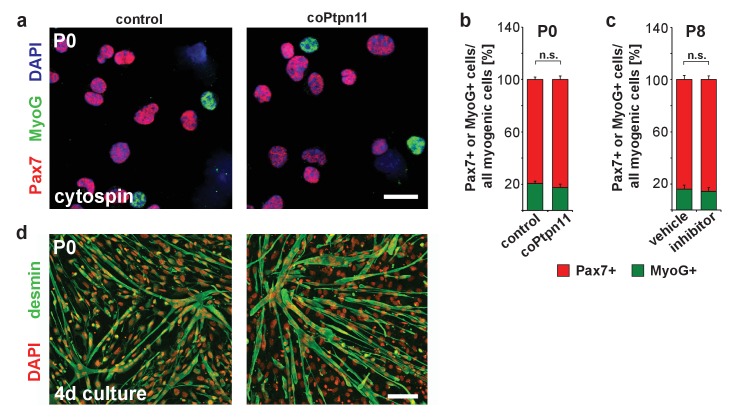
Loss of Ptpn11 does not affect myogenic differentiation.(a) Cytospins of freshly isolated muscle stem cells from control and coPtpn11 mice (P0); cells were immunostained for Pax7 (red) and MyoG (green), and nuclei were counterstained with DAPI (blue). (b) Quantification of Pax7+ and MyoG+ cells in cytospins of cells isolated from control and coPtpn11 mice (P0). (c) Quantification Pax7+ and MyoG+ cells in cytospins of freshly isolated stem cells after donors had been treated with GS493 or vehicle. (d) Immunostaining for desmin (green) of cultured myogenic progenitor cells kept in differentiation medium for 4 days. Nuclei were counterstained with DAPI (red). n.s. = not significant. Error bars show S.E.M. Scale bars 10 µm (a) 50 µm (d).